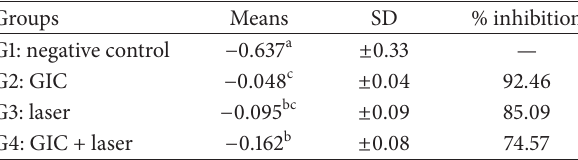
Table 1: QF means for all groups tested.